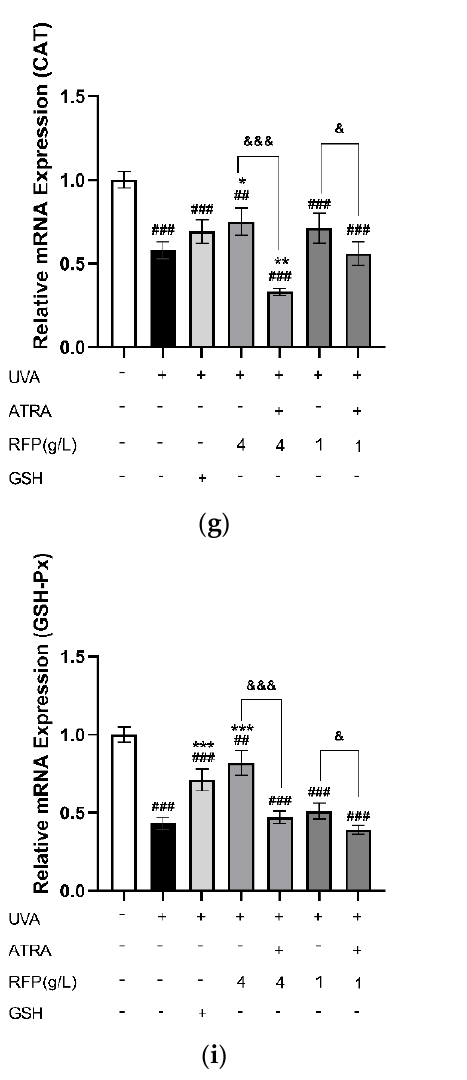
Figure 8. Effects of RFP on transcription expression and content of antioxidant enzymes: ( a ) effect on transcription expression of HO − 1; ( b ) effect on content of HO − 1; ( c ) effect on transcription ex-